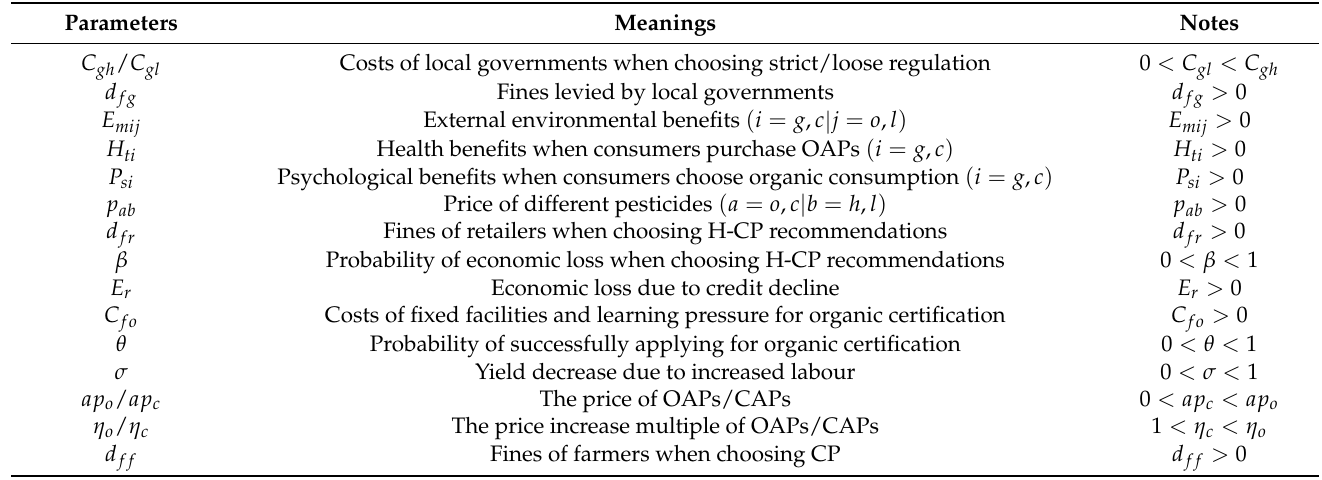
Table 1. The meaning of parameters and notes about them.